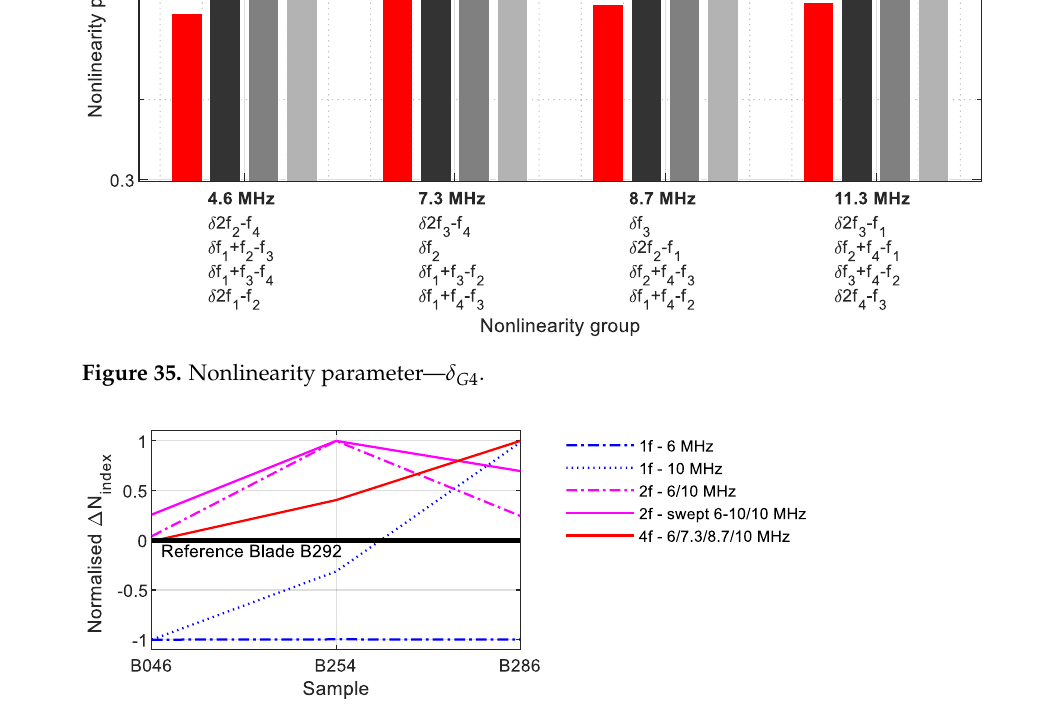
Figure 35. Nonlinearity parameter — δ G4 .